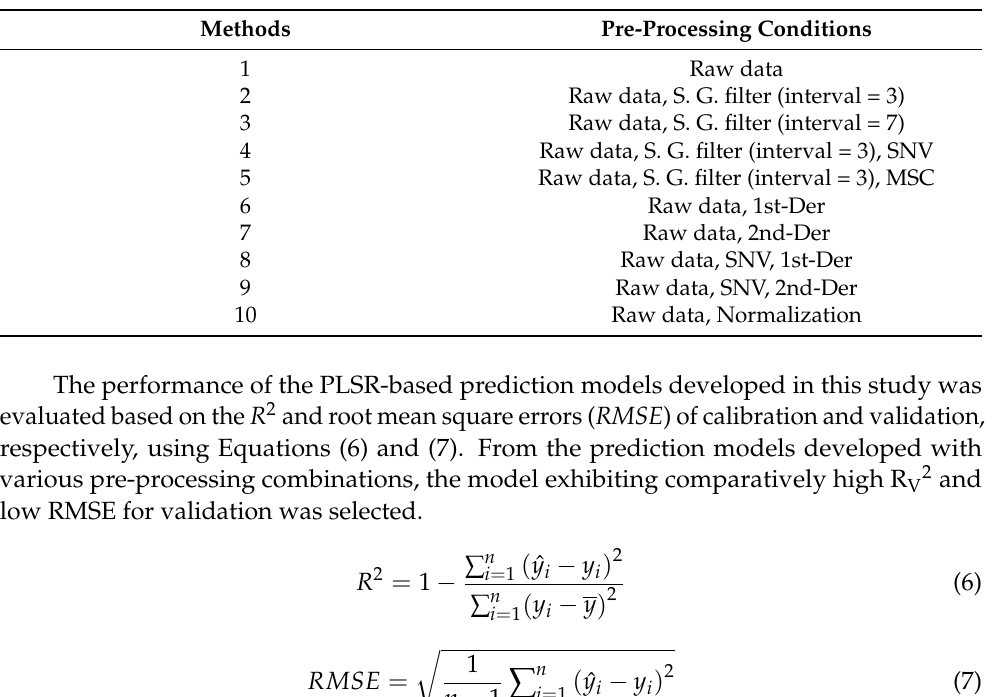
Table 2. Pre-processing combinations tested in this